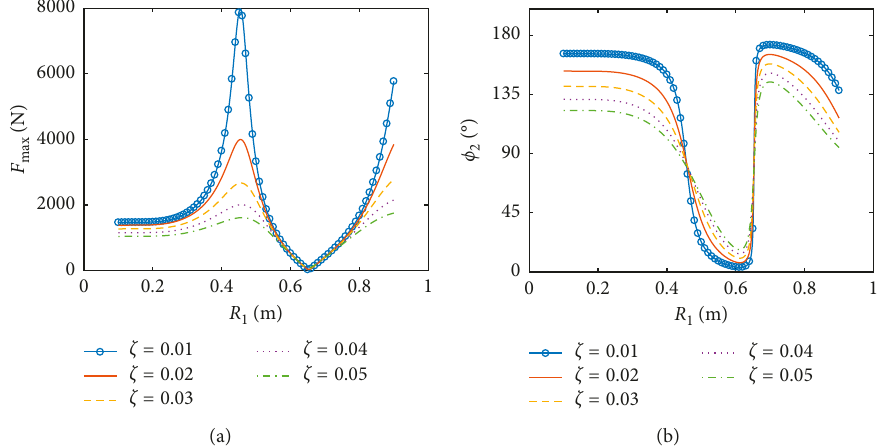
Figure 8: The amplitudes and the phases of the resultant force versus the inner radius of the flexible baffle for z (a) the amplitude of the resultant force, (b) the phase of the resultant force.